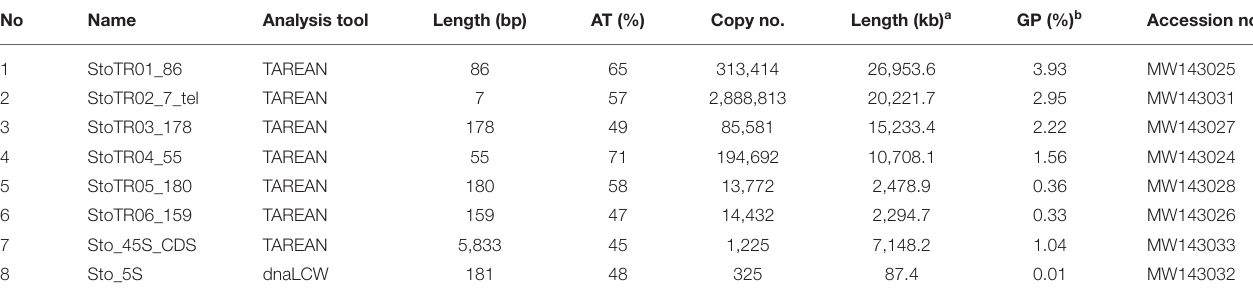
TABLE 1 | Independent tandem repeats identified in the S. tora genome.